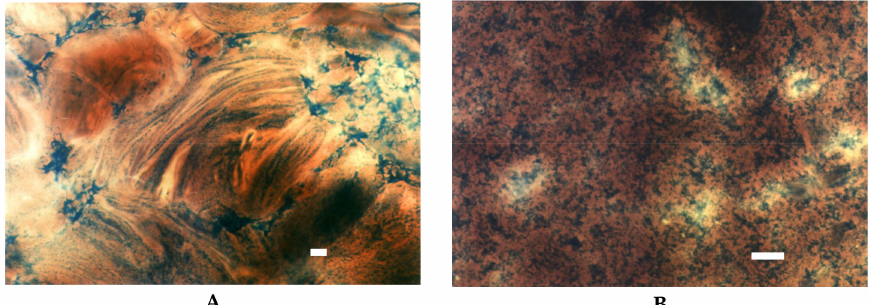
Figure 4. LM micrographs of pregelatinised starch dispersions incubated at a temperature of 25 ◦ for